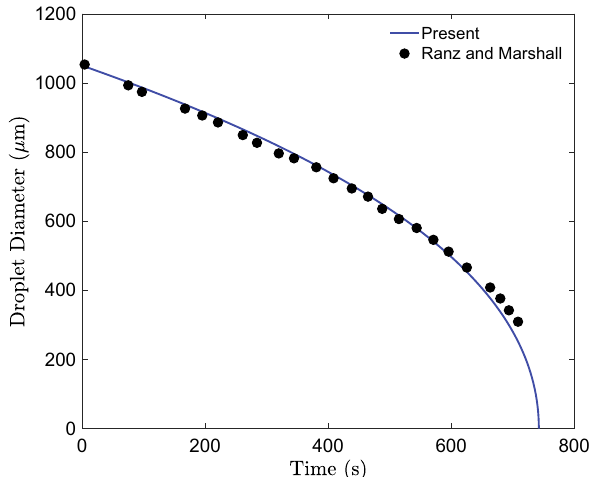
Figure 4. Comparison of droplet diameter as it evaporates with experimental data of Ranz and Marshall 44,45 .